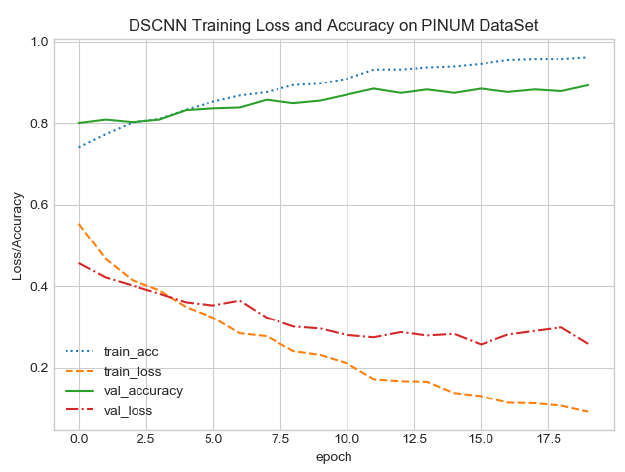
Figure 8. FC-DSCNN training loss and accuracy on the PINUM dataset.